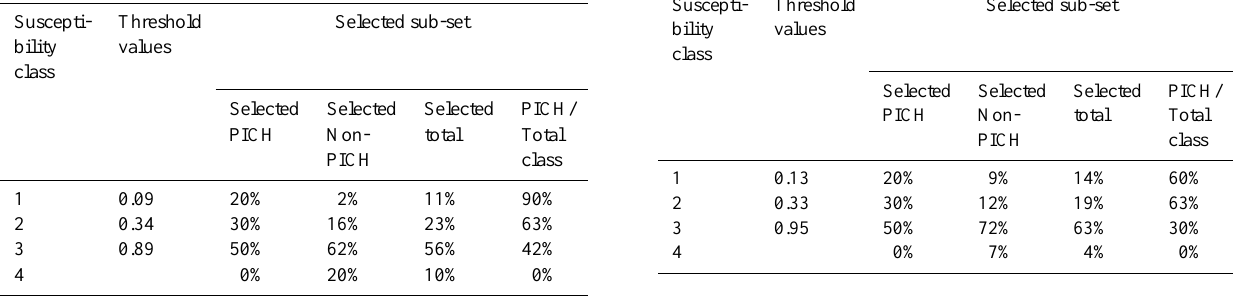
Table 4. The sorting efficiency based on the local slope. Suscepti- Threshold Selected sub-set bility